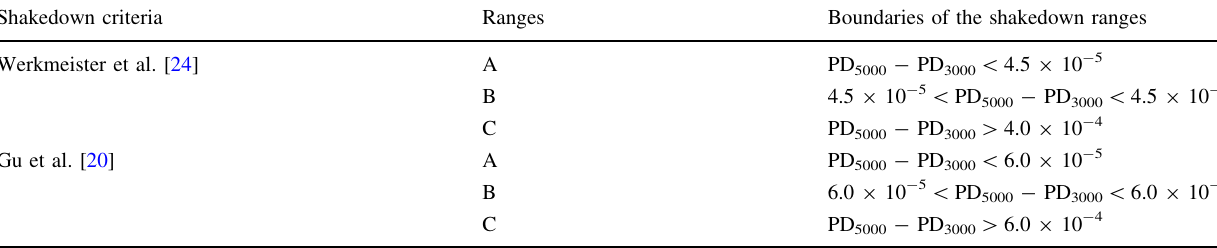
Table 1 Shakedown range boundaries Shakedown criteria Ranges Boundaries of the shakedown ranges Werkmeister et al.